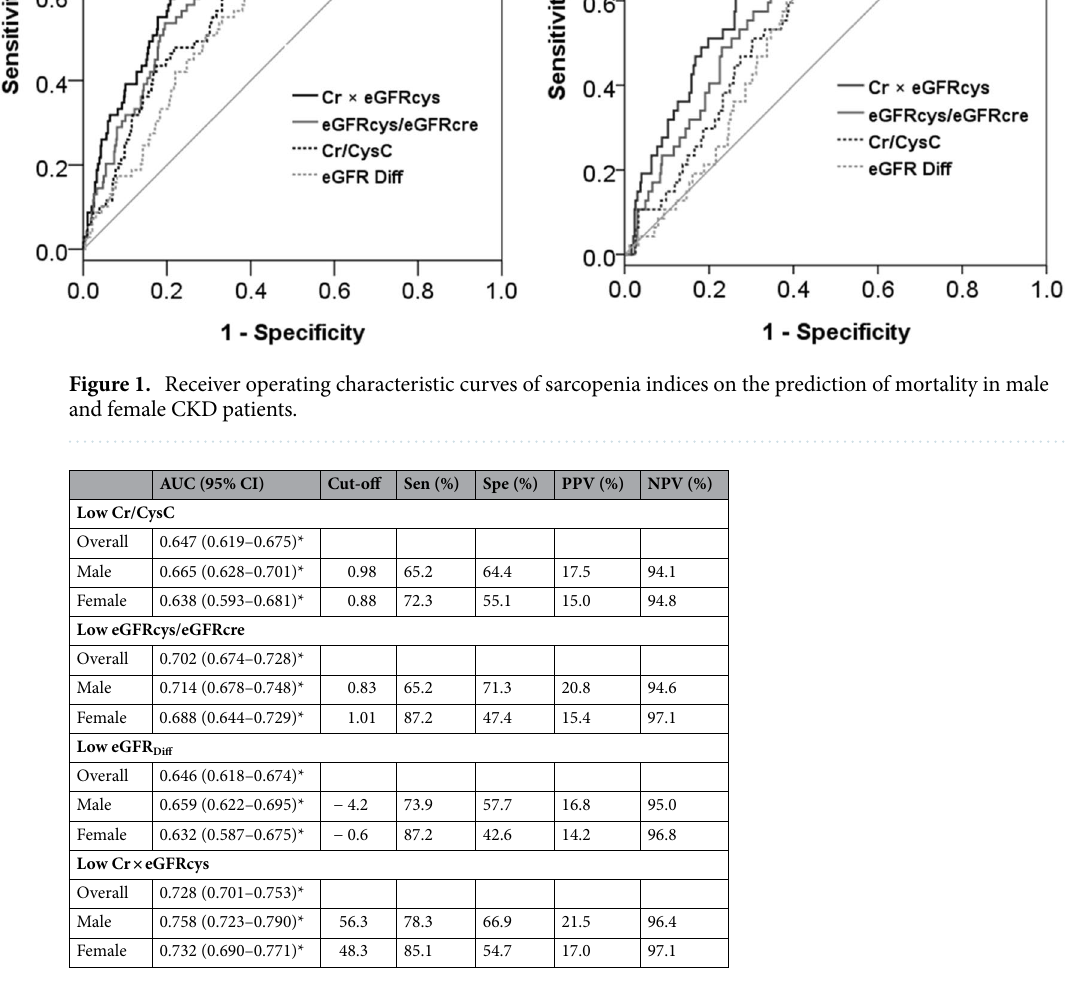
Table 3. Predictive validity of sarcopenia indices on overall mortality, overall and stratified by gender. AUC area under curves, CI confidence interval, Sen sensitivity, Spe specificity, PPV positive predictive value, NPV negative predictive value. *p < 0.05 was considered statistically significant.